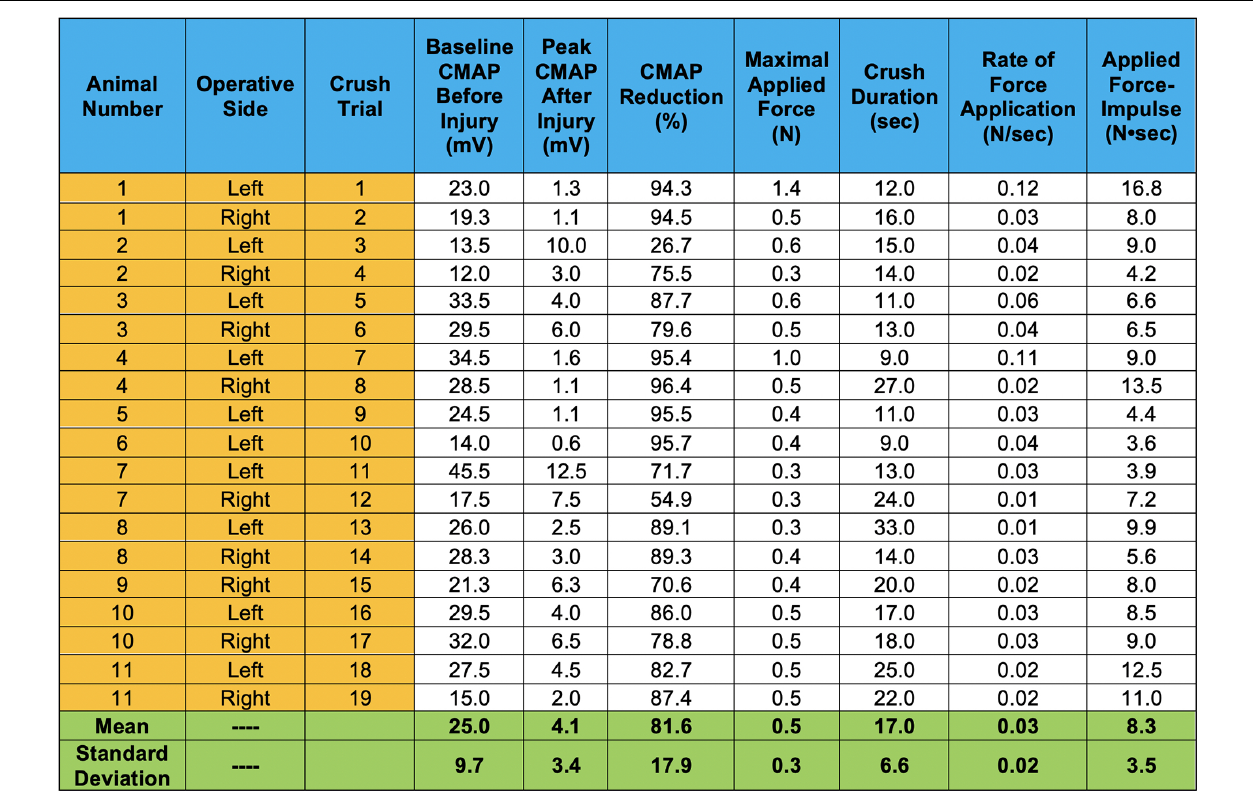
FIGURE 5 | CMAP amplitude responses induced by our controlled compressive nerve lesions are shown. For each trial, CMAPs displayed represent values averaged from dual channel recordings, representing motor unit activity in both the lateral and medial gastrocnemius muscles. Peak CMAP values after injury represent the peaks immediately after the crushing forceps were released and extricated from the nerve. Crush duration represents only the time in which the graded force was applied. Rate of force application represents the slope of the graded force applied over the crushing